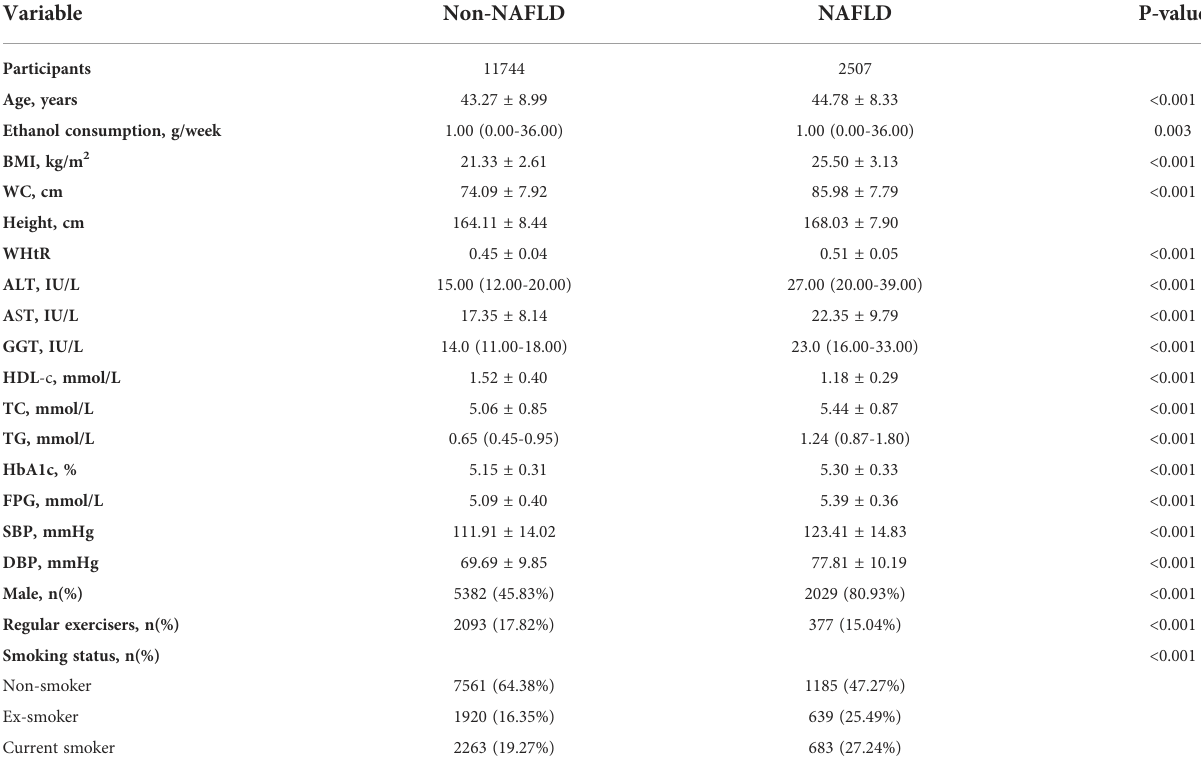
TABLE 1 The Baseline Characteristics of